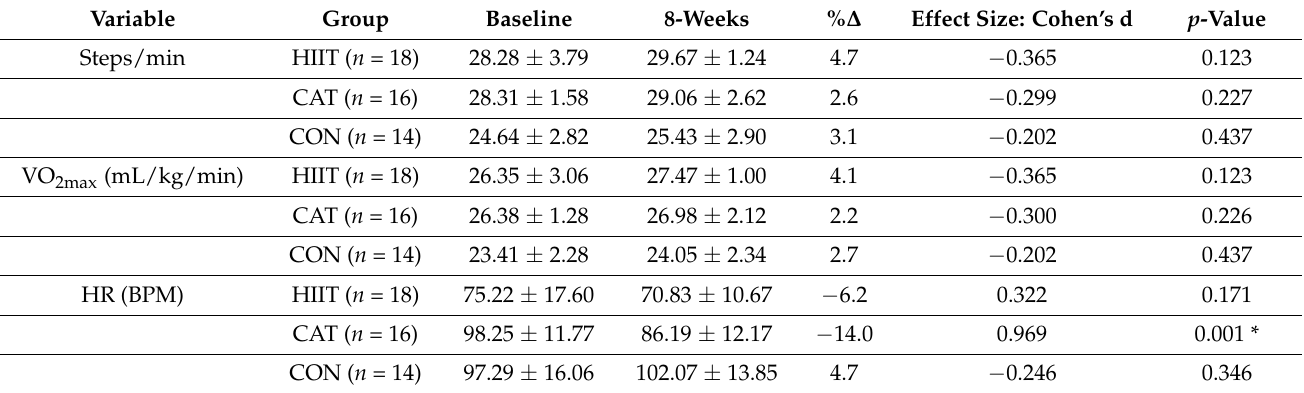
Table 5. Intra-group comparisons of cardiorespiratory endurance variables (steps/min, VO 2max and heart rate) in college-aged smokers following 8 weeks of high-intensity interval training (HIIT), continuous aerobic training (CAT), and a control group